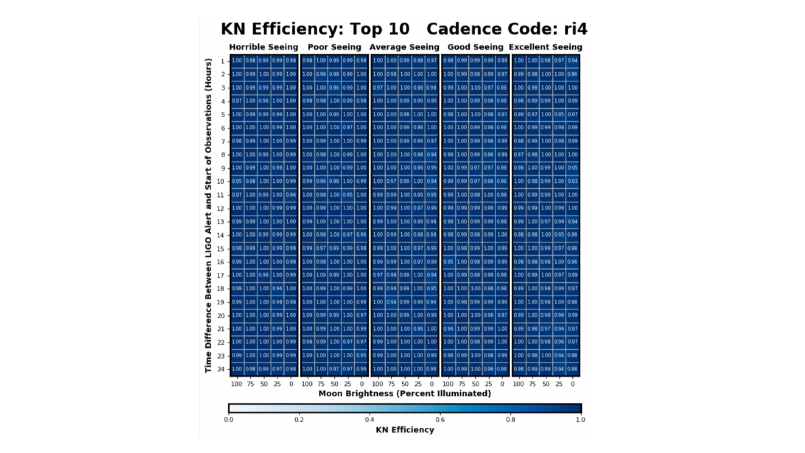
Figure 4. Fraction of the time KN-Classify ranks a KN as one of the ten most interesting candidates out of ∼ 20 , 000 for various observing conditions. The observing cadence used for this plot was two sets of exposures in r , i separated by 1 hour.